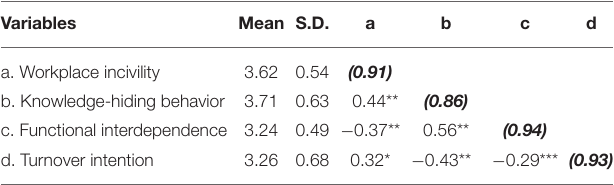
TABLE 1 | Statistics of Uni-variation and correlations between variables.